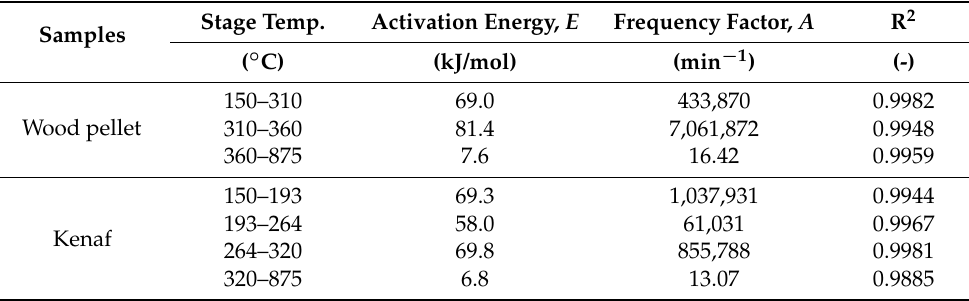
Table 4. Pyrolysis kinetic parameters of biomass samples at a heating rate of 10 °C/min.